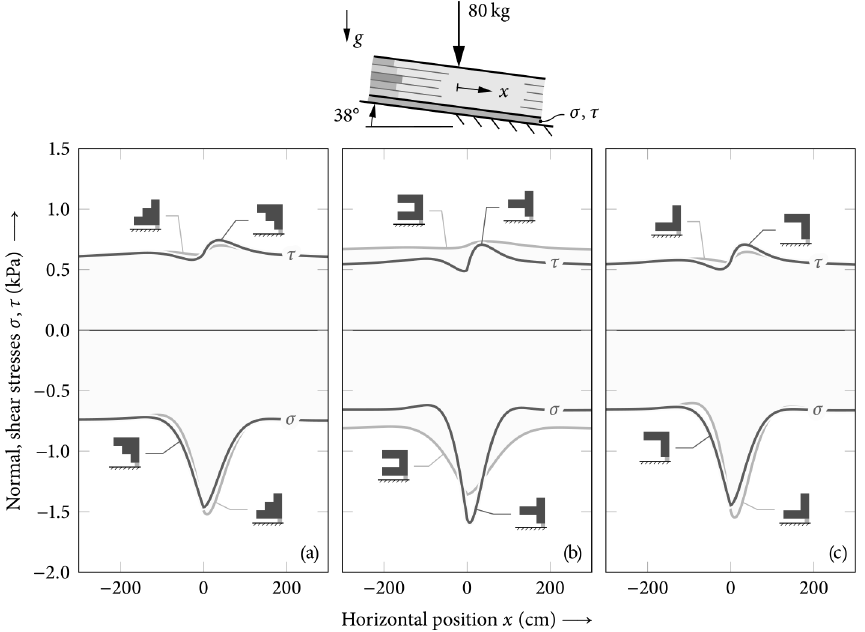
Figure 13. Comparison of shear and normal stresses in the weak layer of inclined skier-loaded layered snowpacks. The central 0.6m section of an infinite slab is shown.